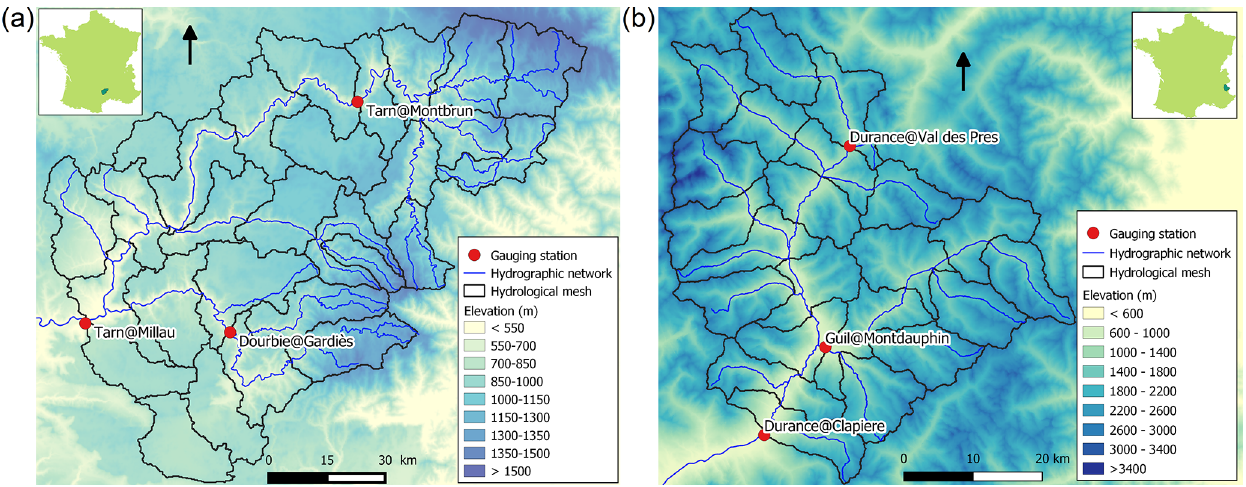
Figure 6. Maps of the catchments studied: (a) Tarn at Millau (2335km 2 ) and (b) Durance at La Clapière (2170km 2